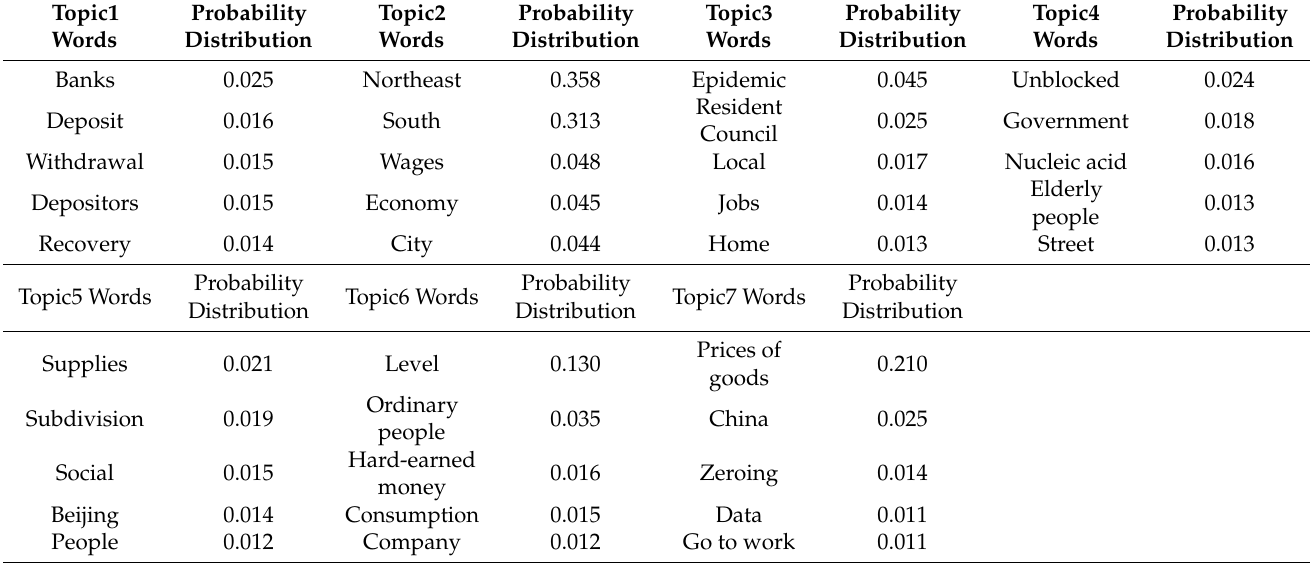
Table 18. C2 LDA theme model results.